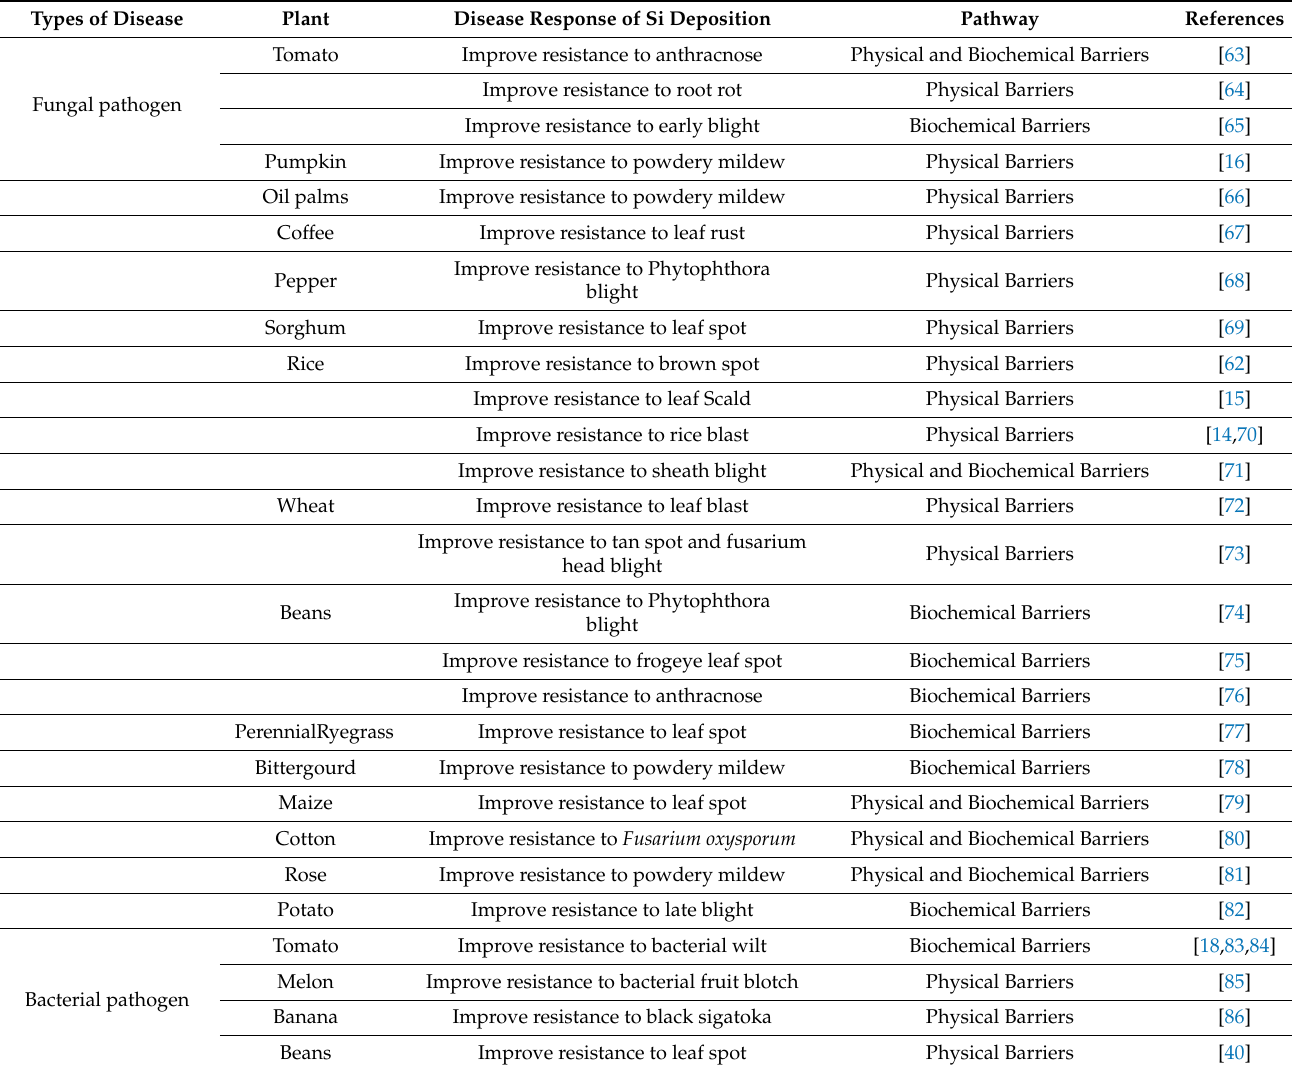
Table 2. Studies showing the beneficial role of Si in alleviating disease-associated